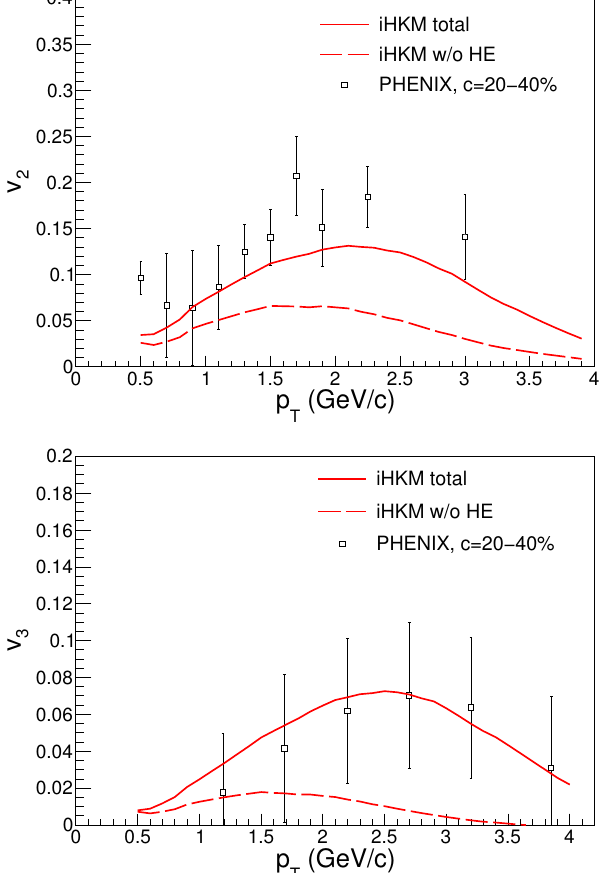
Figure 3. The photon v 2 ( p T ) and v 3 ( p T ) flow harmonics behavior calculated in iHKM for the case of the top RHIC energy Au+Au collisions with the centrality c = 20–40% in comparison with the measured experimental data [71]. The solid lines are related to the simulations where the hadronization emission is taken into account, while the dashed lines represent the simulations where HE was ignored.